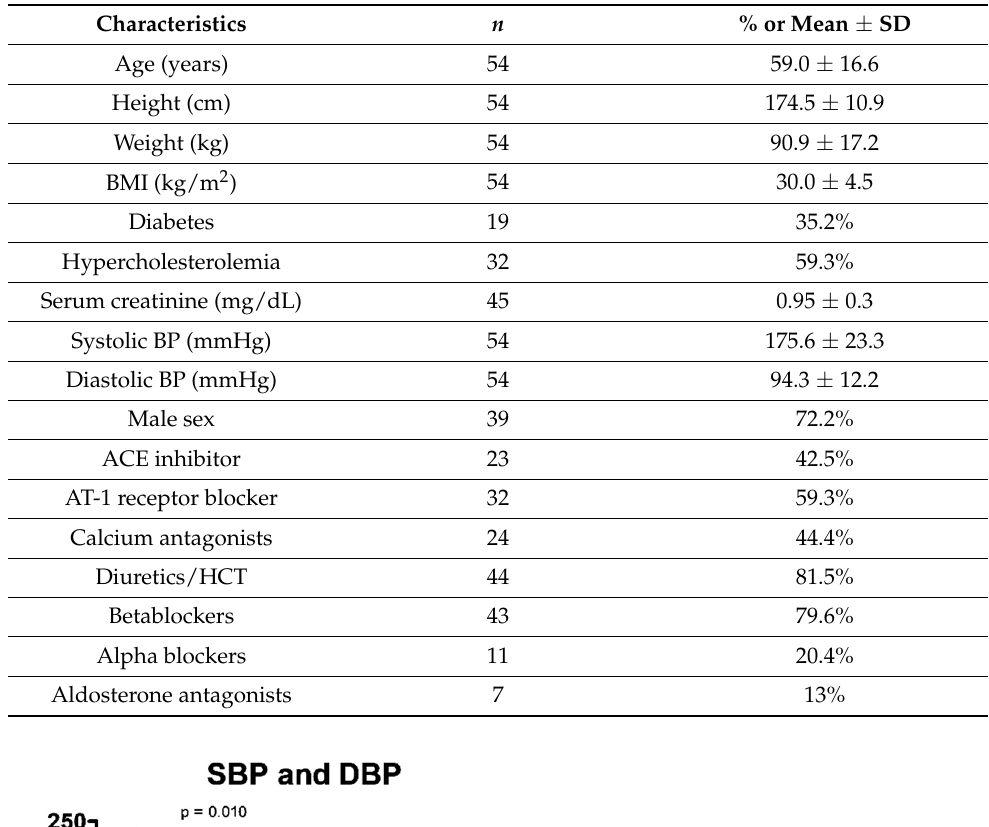
Table 1. Baseline characteristics, comorbidities, baseline BP and antihypertensive regime.